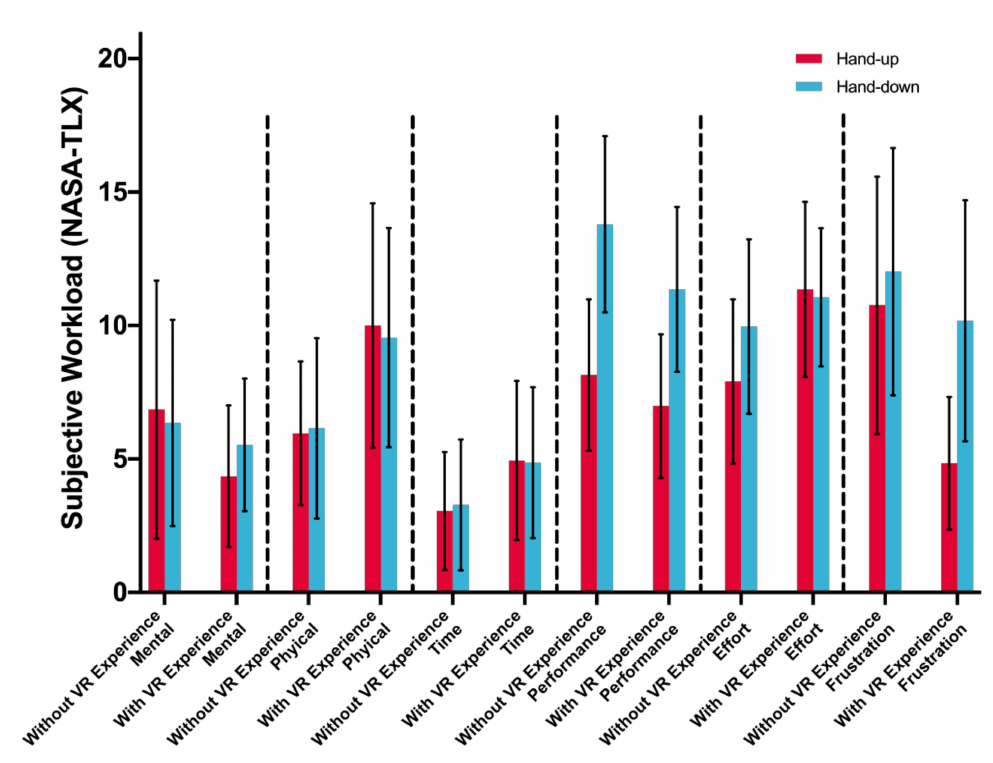
Figure 11. Task workload (six facets of NASA-TLX Scale) of participants when using different postures. Error bars represent 95%